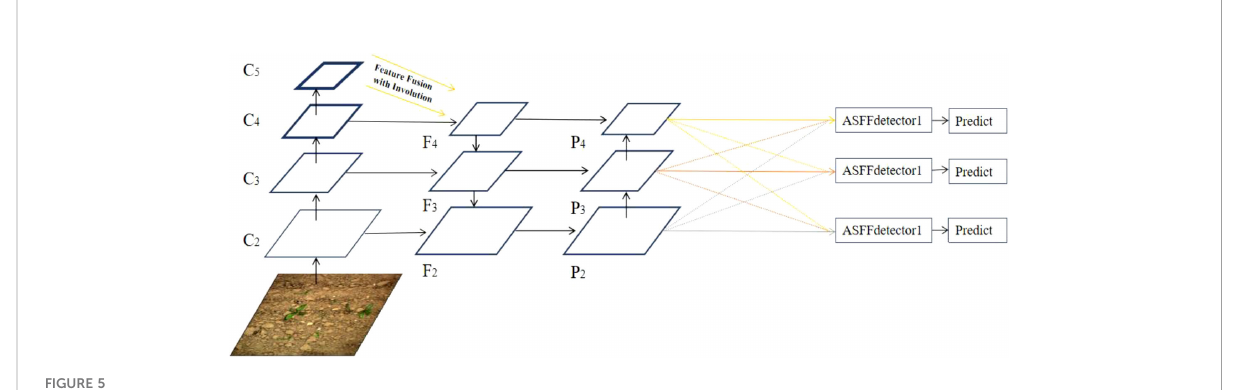
FIGURE 5 Schematic diagram of adaptively spatial feature fusion